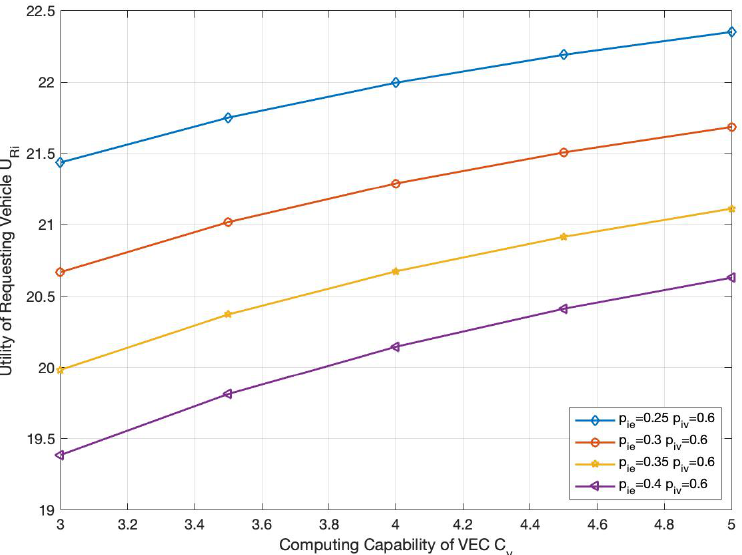
Figure 4. Impact of the processing capability and service price on the utility of requesting